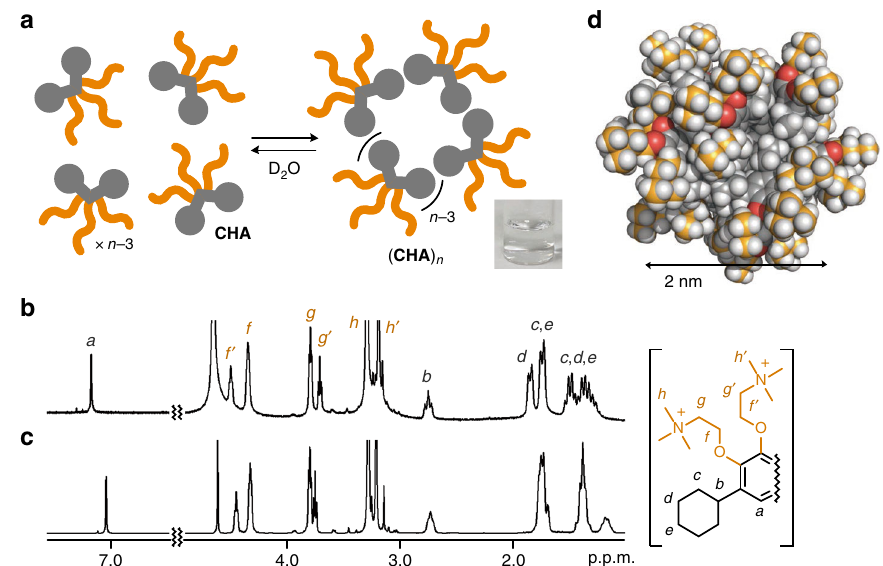
Fig. 2 Formation of the cycloalkane-based micelle. a Schematic representation of the quantitative formation of micelle ( CHA ) n in water and its photograph. Concentration-dependent 1 H NMR spectra (400 MHz, D 2 O, room temperature) of ( CHA ) n at b 10mM and c 170mM based on CHA . Labels a - h ’ are the signal assignment of CHA . d Optimized structure of spherical micelle ( CHA ) 12 (white: hydrogen; gray and orange: carbon; red: oxygen; blue: